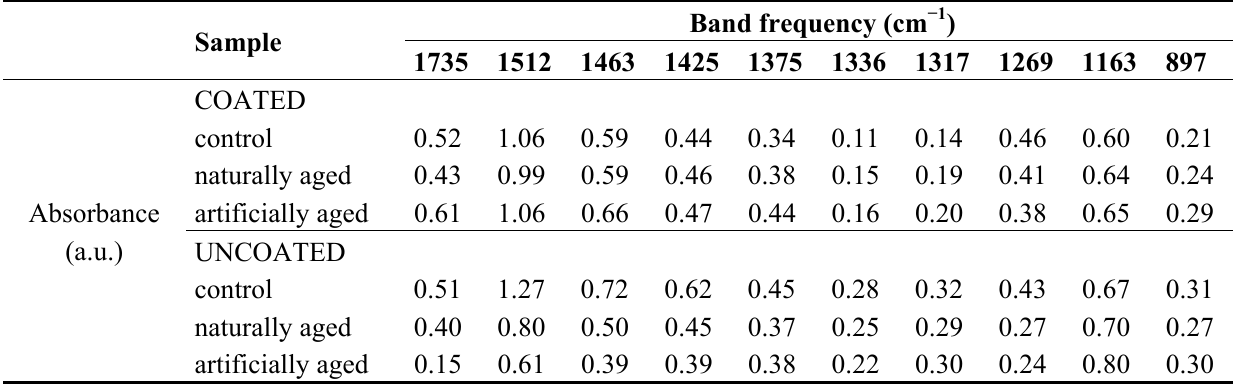
Table 3. FT-IR absorbances average values of wood samples. All values are normalised to 1024 cm − 1